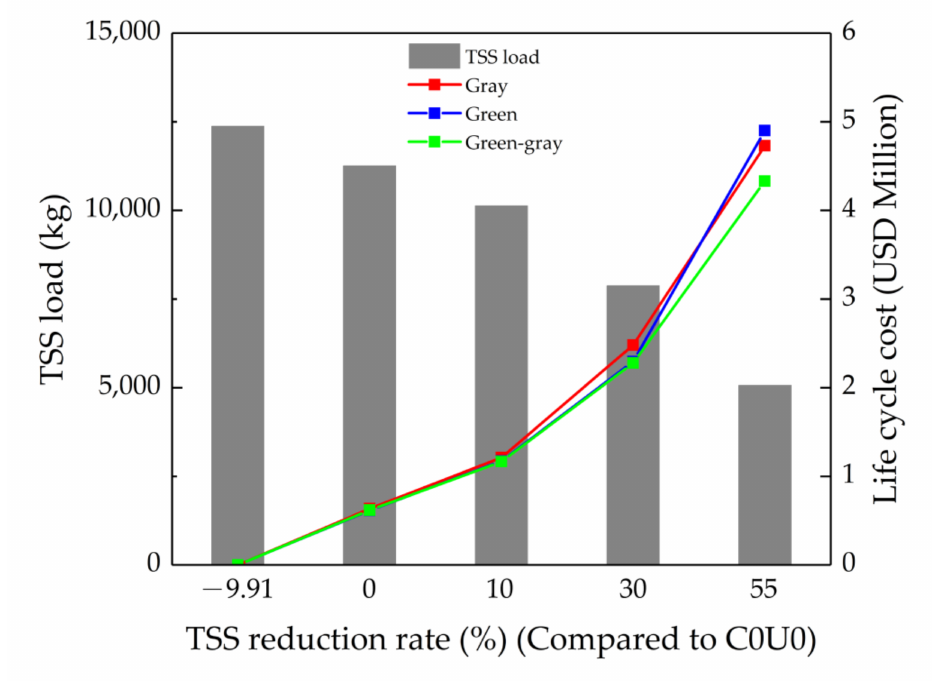
Figure 10. Costs of maintaining the water quality levels to C0U0 under